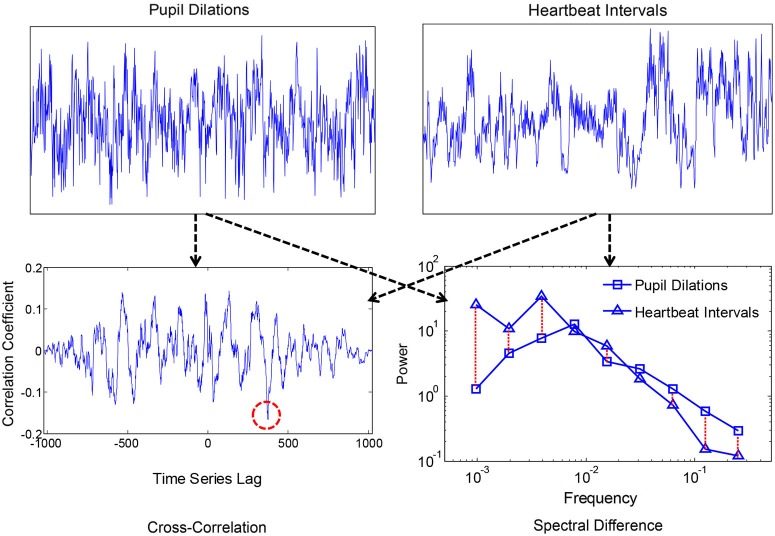
Time series of pupil dilation responses and heartbeat intervals for one participant, along with the corresponding cross-correlation function and spectra. The red dashed circle shows the peak negative correlation, and the red dashed lines between spectra show absolute log differences.